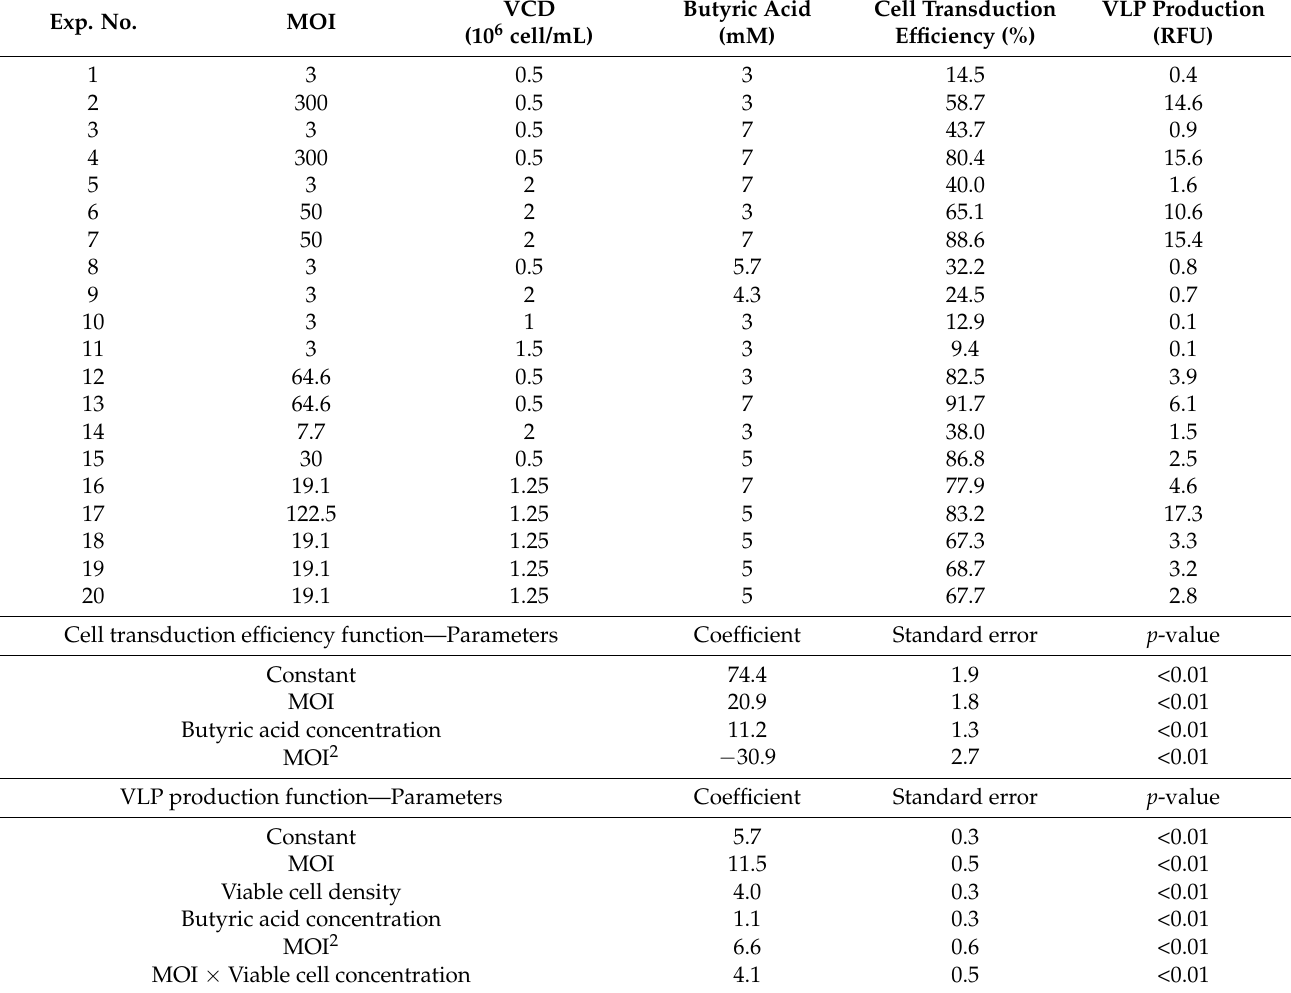
Table 2. Matrix design, responses and ANOVA analysis for the D-optimal design at 48 hpt. Cell trans- duction efficiency (% of eGFP-positive cells) was measured by flow cytometry, and VLP production (RFU) by spectrofluorometry. Run 18, 19 and 20 are replicates to account for pure experimental error. Significant parameters ( p -value < 0.05) are